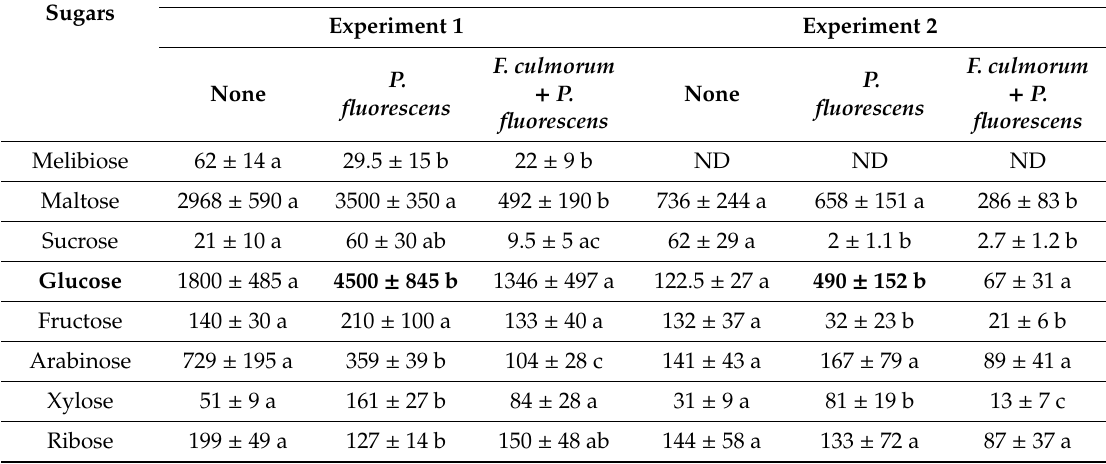
Values in the same experiment with di ff erent letters are significantly di ff erent at p ≤ 0.05 when applying Fisher’s LSD test. Values are means ± standard deviations. ND = not detected. Substances most actively utilized by F. culmorum are marked in